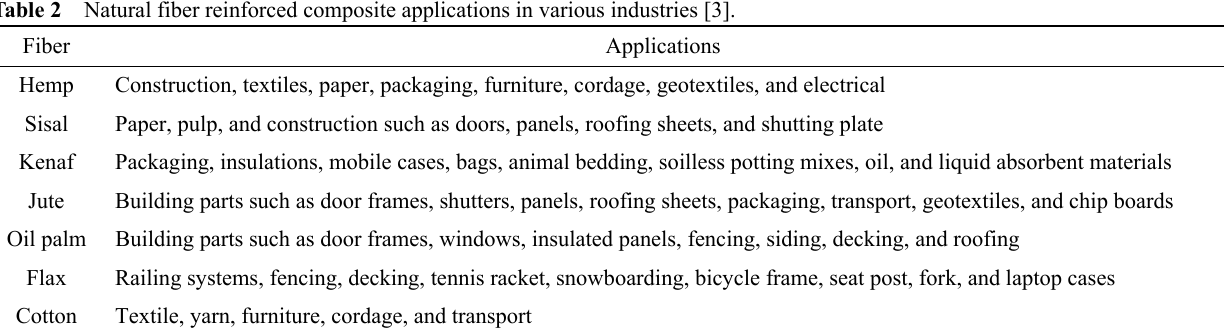
Table 2 Natural fiber reinforced composite applications in various industries [3].